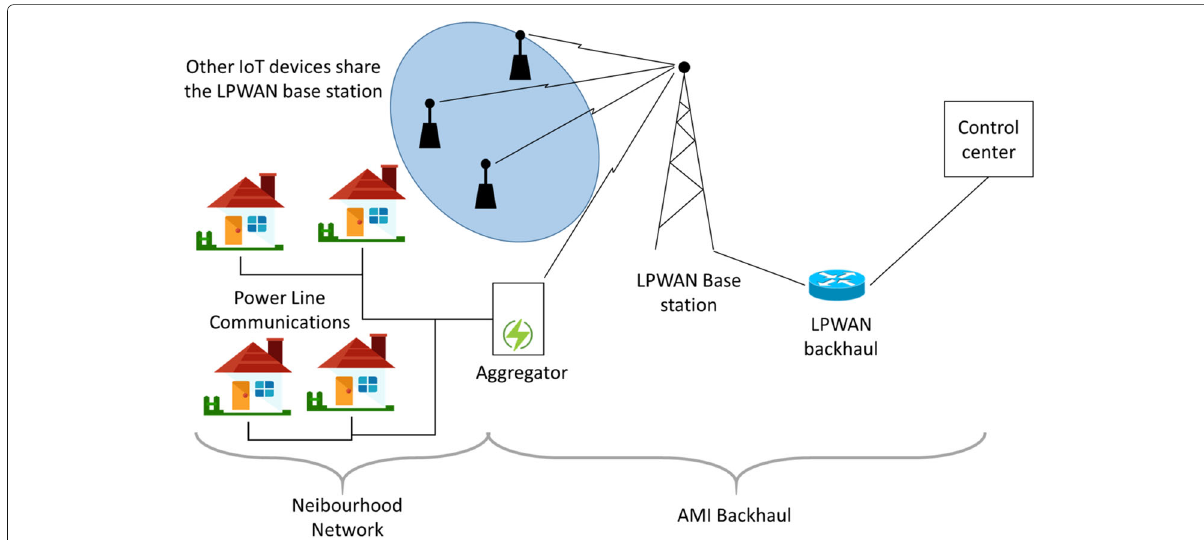
Fig. 1 The AMI backhaul is divided in two parts: the neighbourhood network and the AMI backhaul. In this paper, we focus on the AMI backhaul and more precisely on the communication between aggregators and LPWAN base